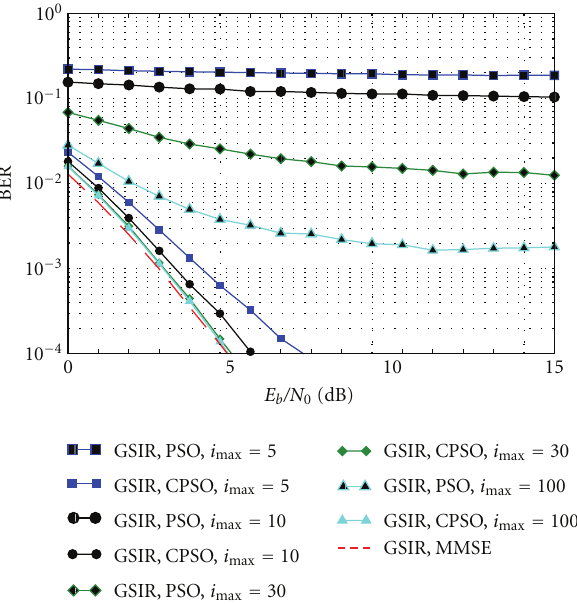
Figure 4: BER performance of the GSIR initialized by PSO, CPSO, and MMSE as a function of the maximum number of